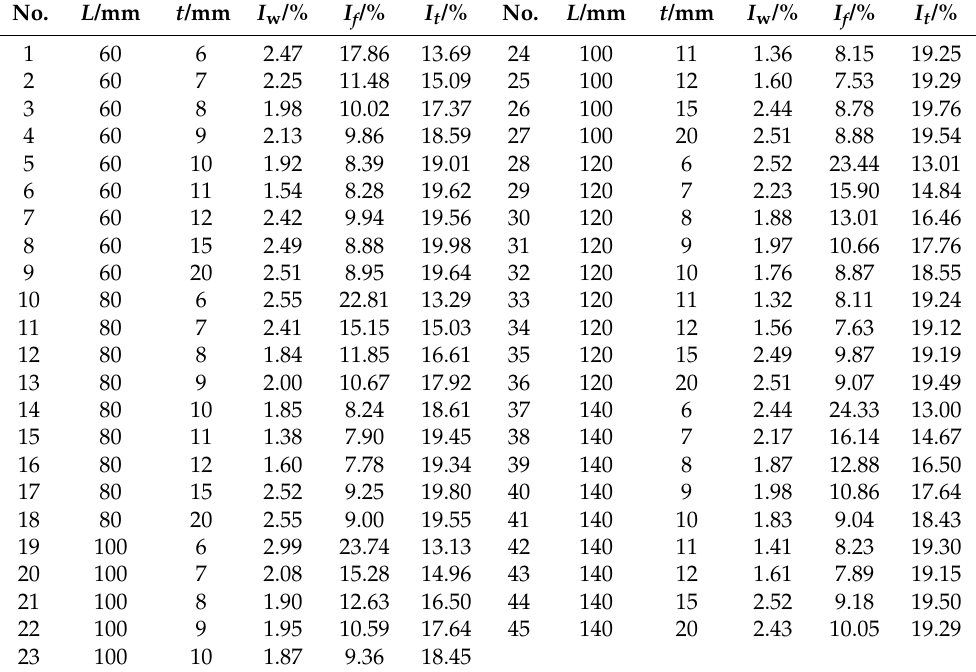
Table 6. Hollow mandrel scheme 1 forming